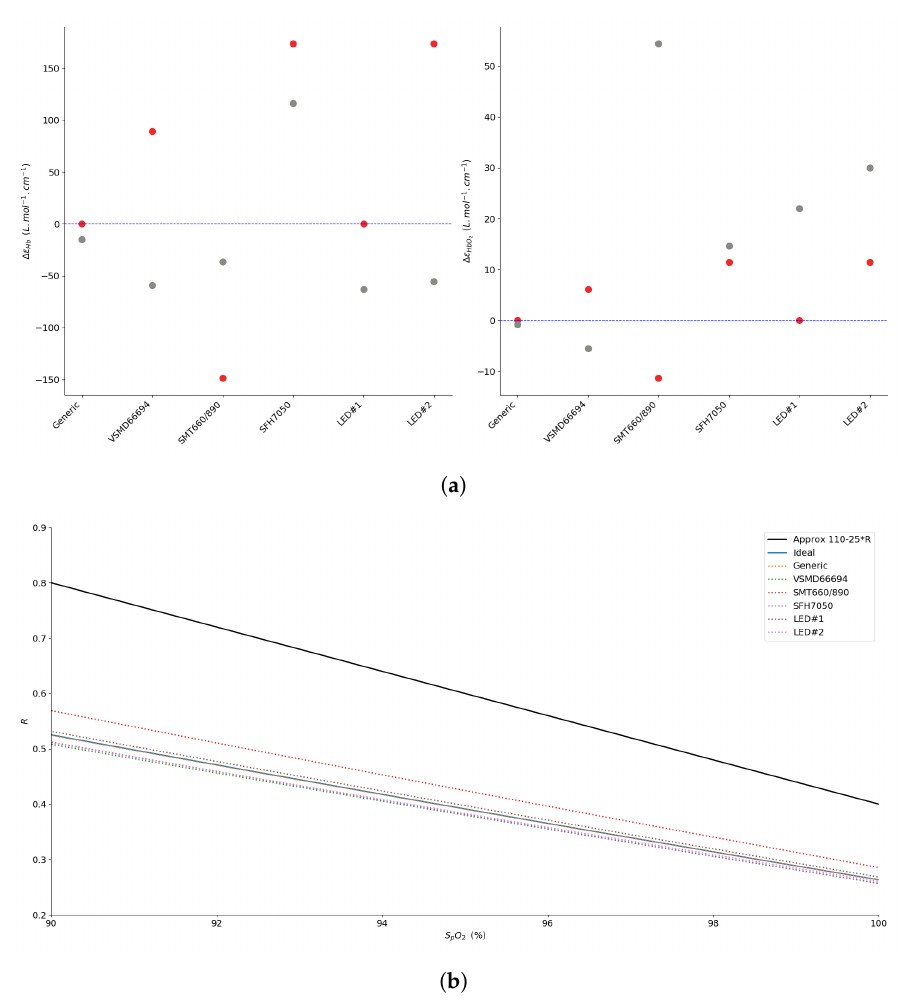
Figure 4. ( a ) Evaluation of the differential shift from the standard values of ε Hb and ε HbO different pairs of sources (red dots for the red source and grey dots for the IR source) with the TSL12T photodetector. ( b ) Simulation of the deviation from the linear approximation according to the Beer–Lambert Law (BLL) for different R-IR sources, zoom in the 90–100% region of